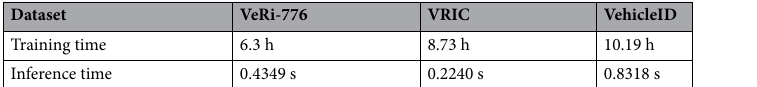
Table 9. Training and inference computation times of our model for the three vehicle datasets. Inference time = TestingSize(img) ÷ BatchSize(img) ×